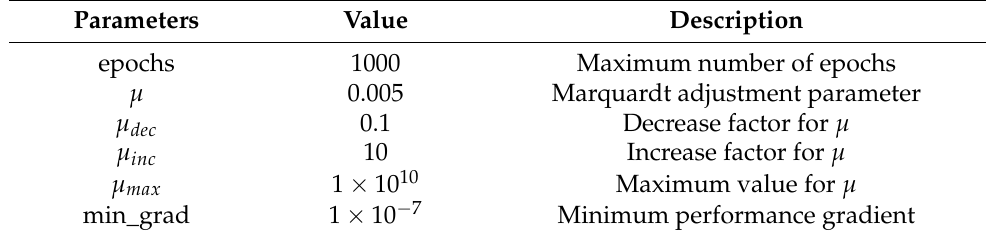
Table 1. Paratmeters used for neural network